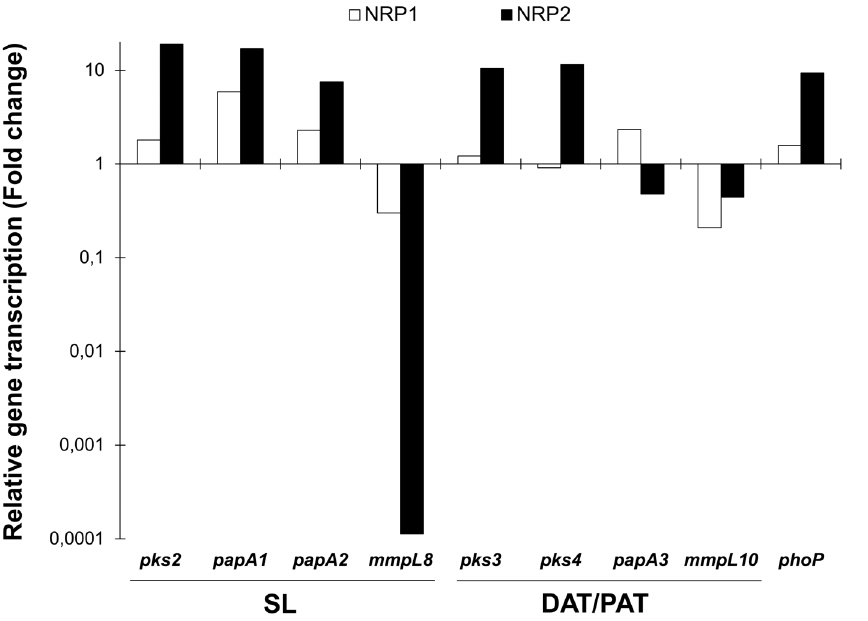
Figure 3. Invitro transcription of genes in M.tuberculosis H37Rv during the NRP1 and NRP2 stages. The relative quantification is expressed as the ratio of NRP1 and NRP2/transcription of exponential-oxygenated phase. The presented data have statistically significant differences compared to exponential phase values ( P , 0.05).